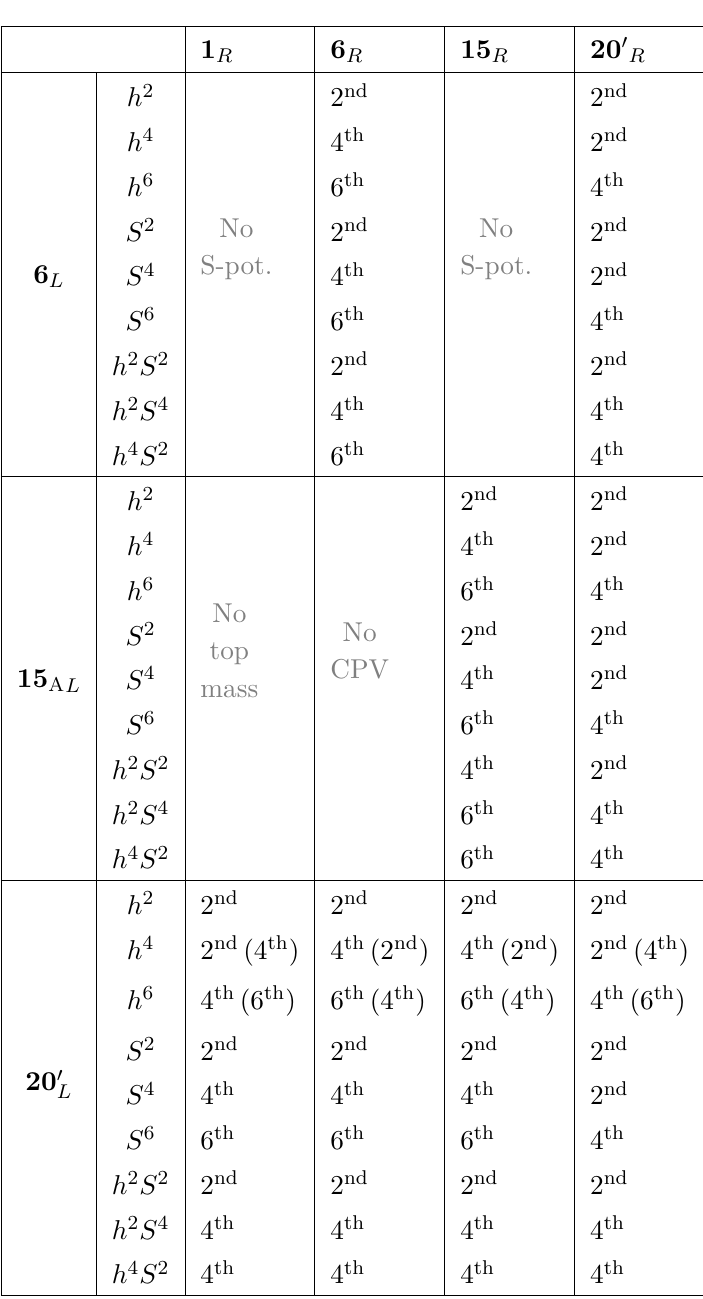
Table 5 . Overview of V ( h, S ) terms arising at n th order in spurions, with brackets denoting special cases of embeddings described in the text (not noting the cases for which S remains a Goldstone boson), i.e., in the 20 0 L block, θ 20L = 0 in the first column, θ 20L 6 = 0 for the second and third and θ 20R1 = 0 for the ( 20 0 , 20 0 ) R A L